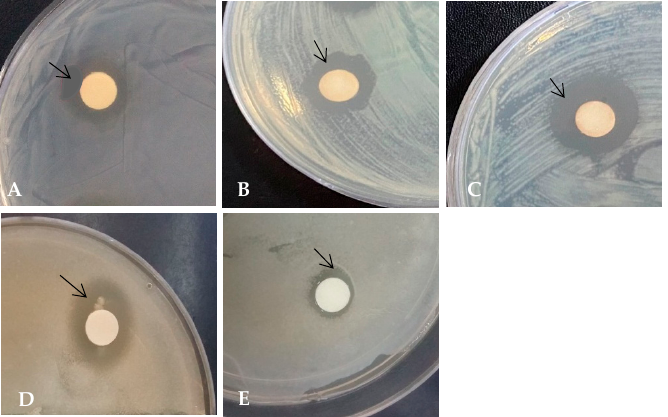
tracts resulted in more dead cells.